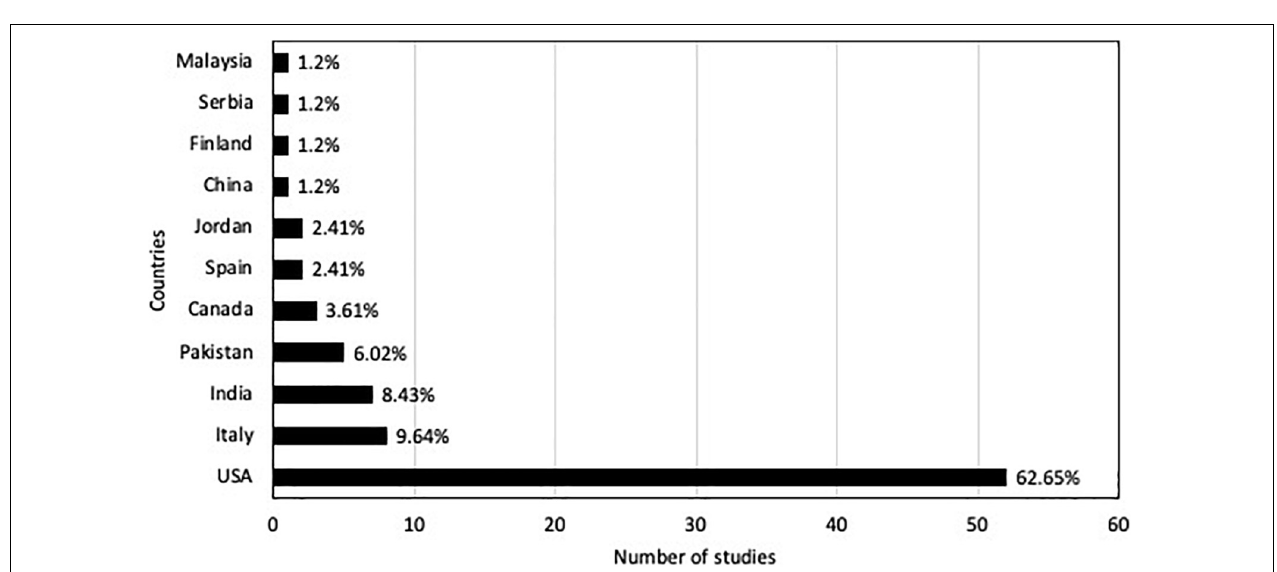
FIGURE 2 | Countries of the studies reported in the articles used for the meta-analysis.